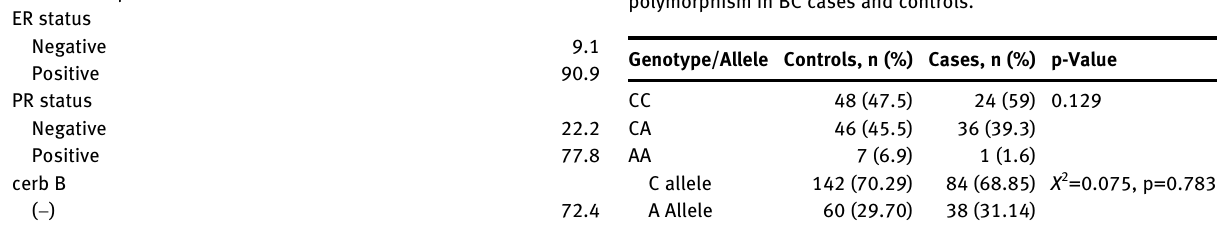
Table  : Genotypes and allele frequencies for PIK  CA C>A gene polymorphism in BC cases and